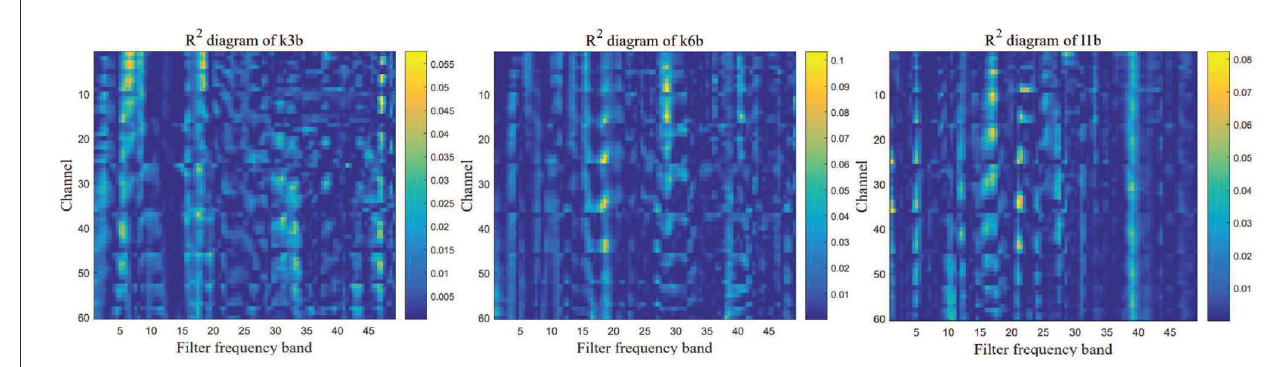
FIGURE3 R 2 chart for three EEG datasets. The more information the frequency band contains, the closer is the color to yellow. Therefore, the bandpass filter parameters of each dataset can be